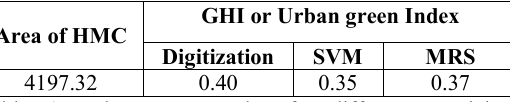
Table 4: Urban green Index for different Municipal Corporations taken in this study 3.5 Per-Capita Green Cover Per capita green space for HMC is represented in (Table 5). Per-capita green space was 9.70 m 2 /inhabitant after including agricultural portion. Per capita green space is estimated from WHO standard reported 9.5 m 2 /inhabitants.